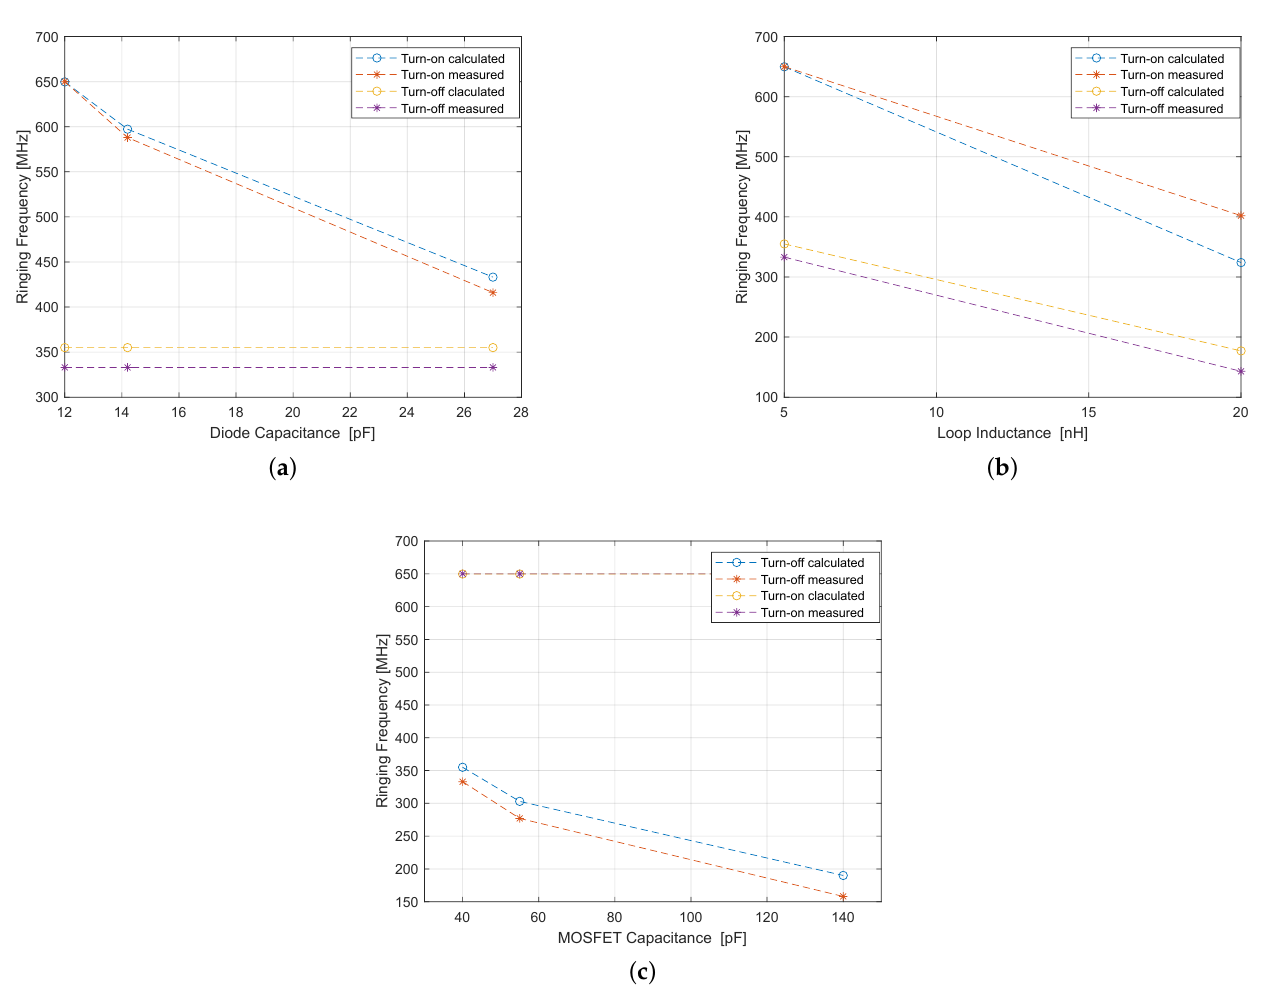
Figure 10. Influence of circuit parasitics on the ringing frequency during turn-on and turn-off. Data were obtained by adding ( a ) additional capacitors across the diode, ( b ) additional inductors into the current loop, ( c ) additional capacitors across the MOSFET.